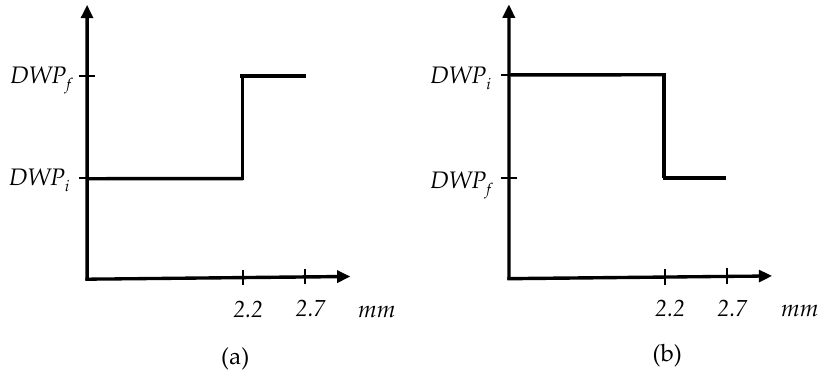
Figure 2. FSSW welding parameters as a stepwise variation function ( a ) dynamic welding parameter ratio R DWP > 1 ( b ) dynamic welding parameter ratio R DWP < 1.